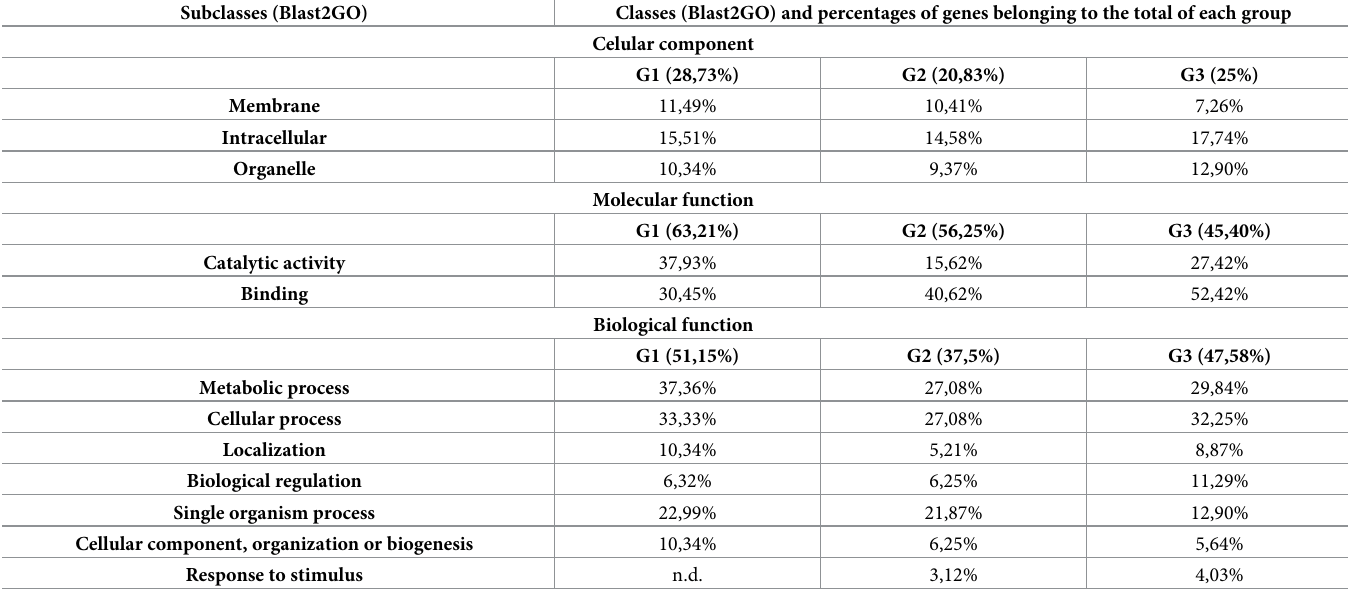
Table 3. Discrimination of distribution profiles of genes belonging to groups G1, G2 and G3 in classes and subclasses of the first level of analysis in the Blast2GO